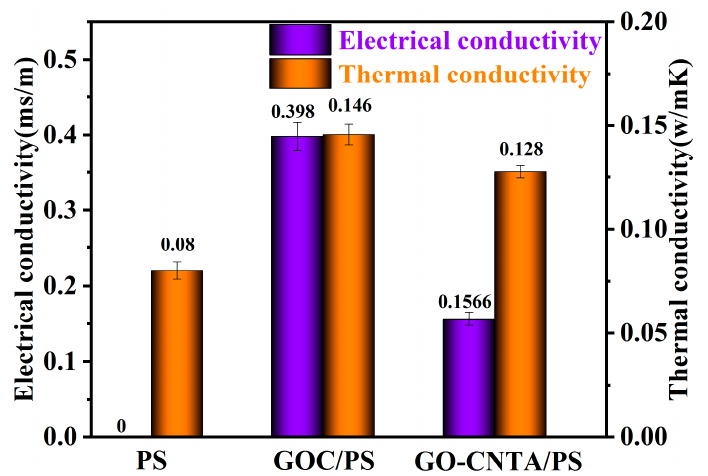
Figure 10. Electrical and thermal conductivity of neat PS, GOCA/PS and GO-CNTA/PS.